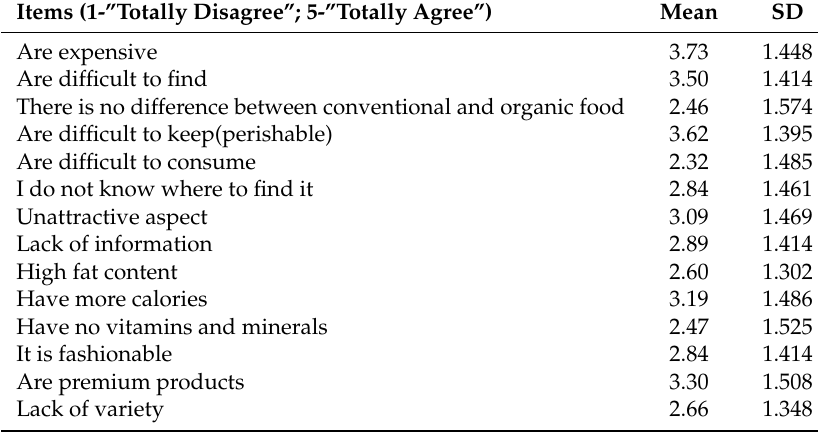
Table 3. Barriers in organic food products